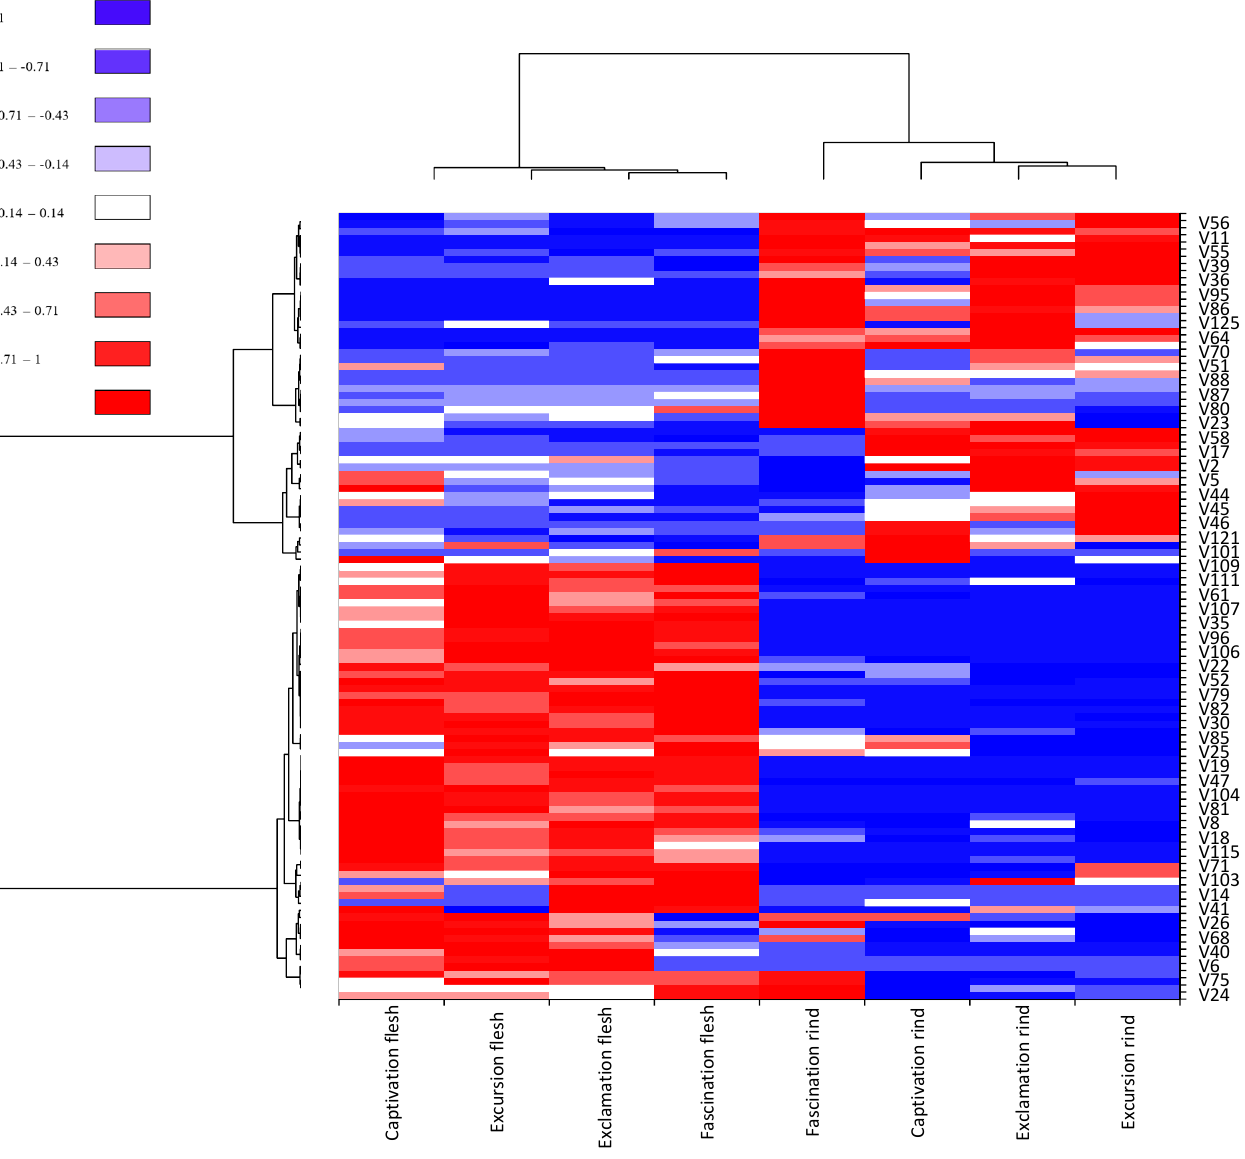
Figure 3. Heat map of 55 selected volatiles (% peak area, filtration interquartile range threshold = 0.01) in the rinds and fleshes of Captivation, Exclamation, Excursion, and Fascination watermelons. Volatile compound names for V1–V132 could be found in Table 1. V = volatiles.